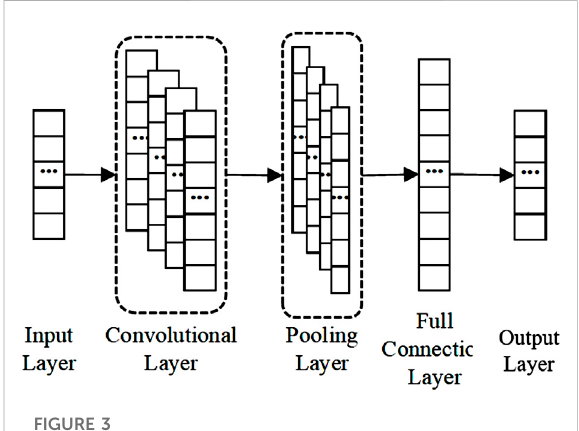
FIGURE 3 The structure of one-dimensional the CNN.